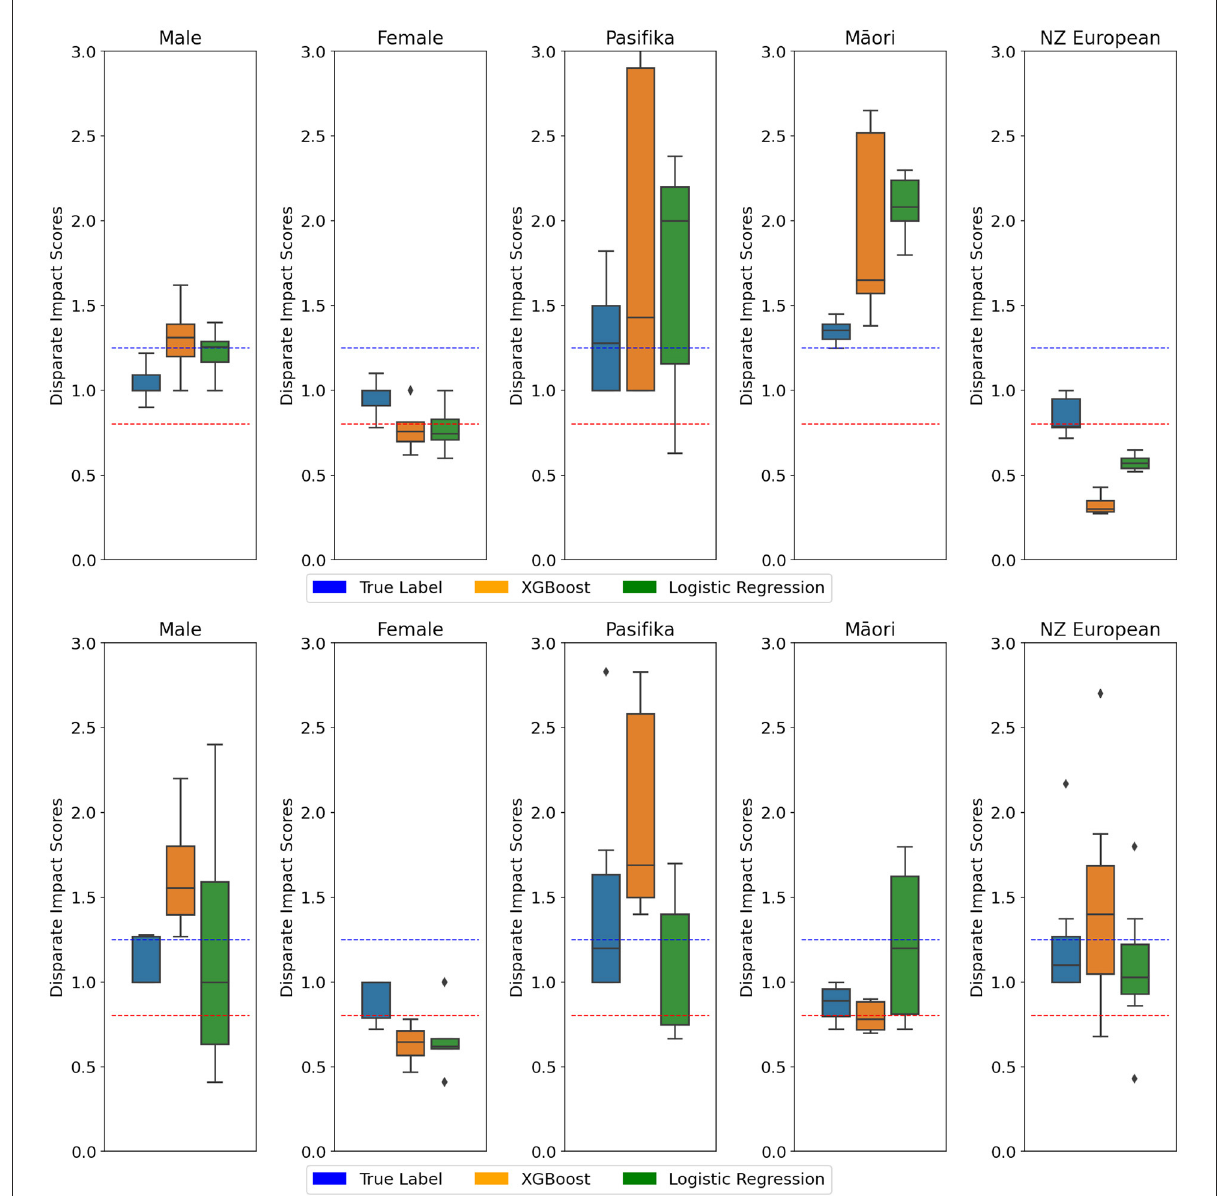
FIGURE6 (Top) NZ-GP Harms data with the target as preventable Harm. (Bottom) NZ-GDF hospital mortality prediction. Protected group: Gender and Ethnicity. Ten cross-validations are performed using two classifiers, and the DI score is calculated at each fold. DI values of true values are also included. Each box plot ranges from minimum to maximum values of DI scores calculated at each fold. DI scores closer to 1 are better. DI < 0.8 implies bias against group (indicated by red line), DI > 1.25 implies bias for group (indicated by blue line).